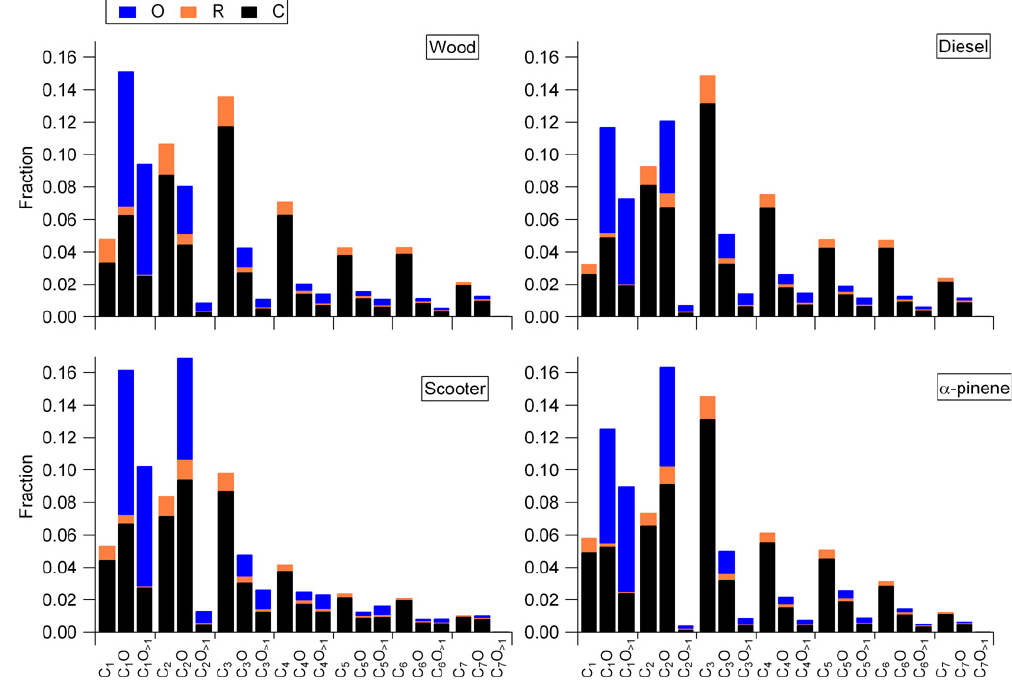
Fig. 6. Averaged normalized bar graphs for the different sources after five hours of aging. The bars represent the ion groups C x , C x O 1 and C x O > 1 for the number of carbon atoms, x , in the range of 1 to 7. The individual bars are split in the contribution of carbon (black), oxygen (blue) and all other atoms, e.g. H or N